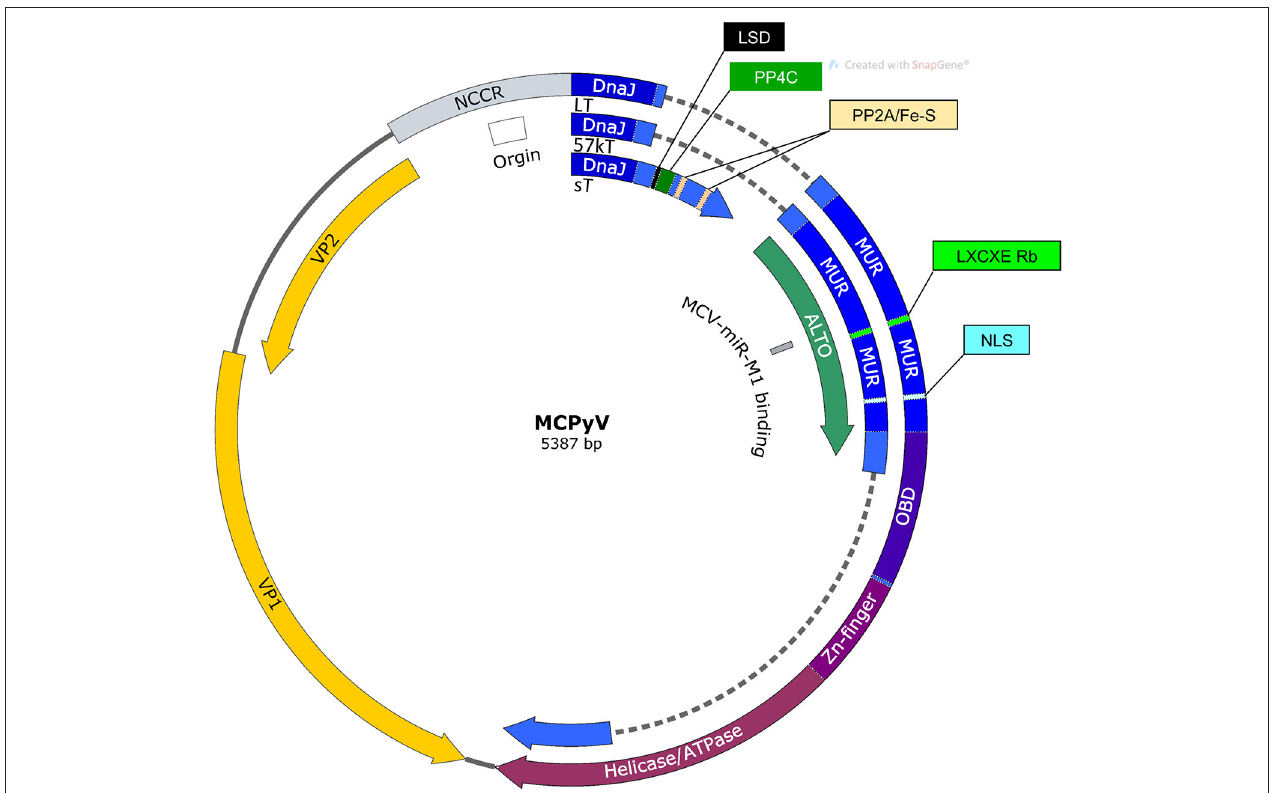
FIGURE 1 | Map of MCPyV genome. NCCR, Non-coding control region; Origin, Origin of replication; LSD, LT stabilization domain; NLS, Nuclear localization signal; MUR, MCPyV unique region; OBD, Origin binding